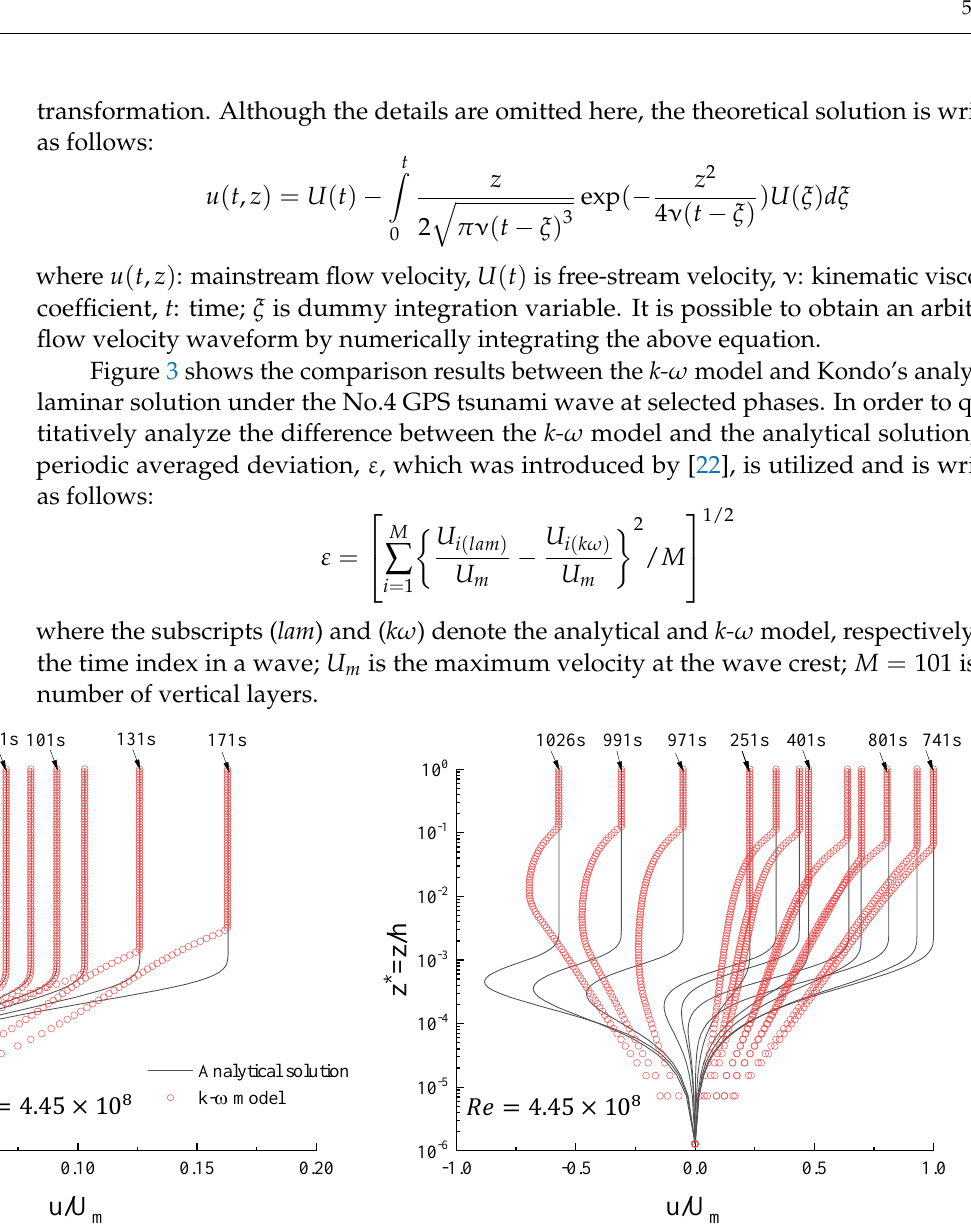
Figure 3. Comparison of the velocity profile for the case No. 4 between the k- ω model and the analytical laminar solution.